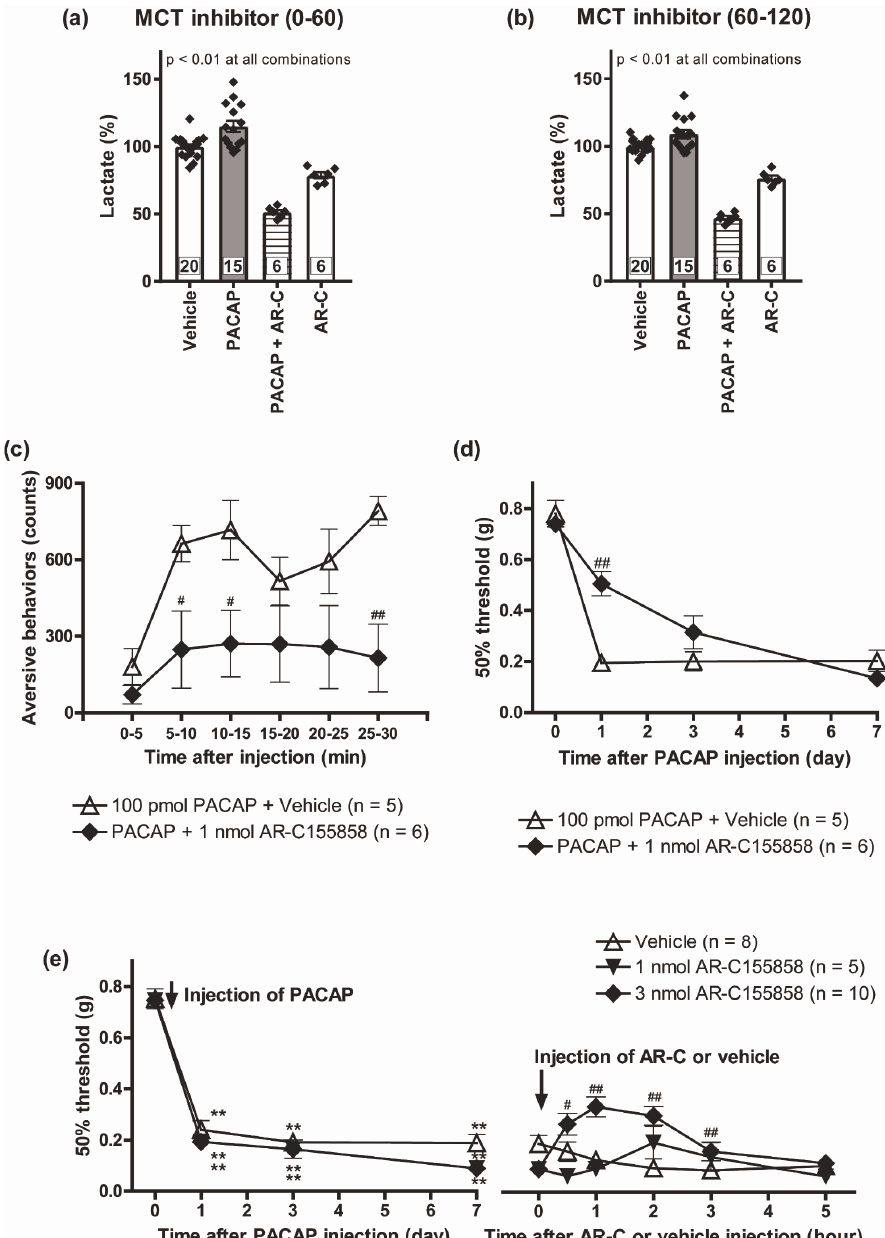
Figure 6. Spinal MCTs contributed to both induction and maintenance of the PACAP/PAC1 receptor- induced nociceptive behaviors. Cultured spinal astrocytes were pre-incubated with AR-C155858 (AR-C, 1 µ M) 30 min prior to PACAP exposure, and then exposed to PACAP (1 nM) for 120 min. The culture supernatants were separately harvested for 0–60 min ( a ) or 60–120 min ( b ) after the PACAP addition, and L-lactate amounts in the culture supernatants were measured. ** p < 0.01 (compared groups are indicated above). Exact sample sizes are indicated in the graphs. Intrathecal co- administration of AR-C155858 (1 nmol) with PACAP reduced the expression of the aversive behaviors ( c ) and mechanical allodynia ( d ). # p < 0.05 and ## p < 0.01 when compared with PACAP + Vehicle data. ( e ) Transient reversal of the PACAP-evoked mechanical allodynia by intrathecal AR-C155858 injection. AR-C155858 was injected 7 days after intrathecal PACAP injection. ** p < 0.01 when compared with pre-PACAP data. # p < 0.05 and ## p < 0.01 when compared with vehicle-treated control. Statistical significance was evaluated by the Tukey test for ( a , b ), Student t -test for ( c ), Mann–Whitney U test for ( d ) and Steel test for ( e